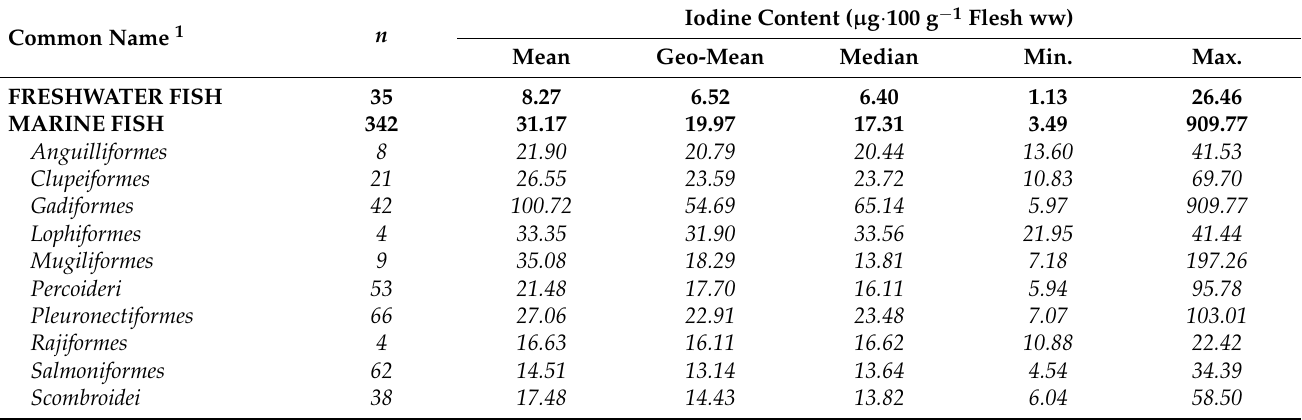
Table 2. Iodine content of seafood ( µ g · 100 g − 1 flesh ww) based on the different seafood